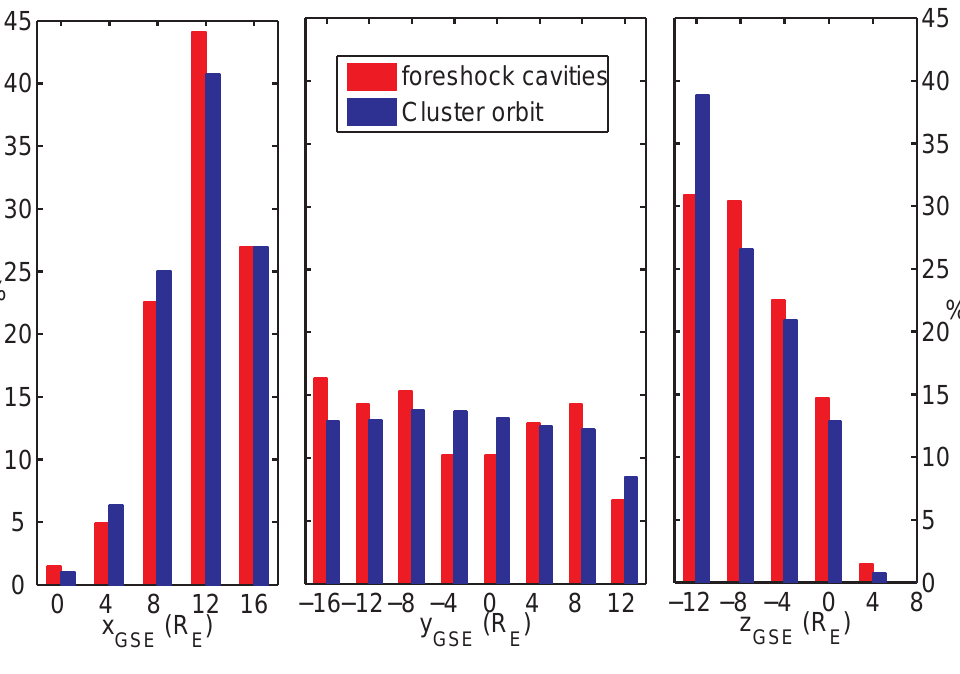
Fig. 3. Histograms of cavity locations projected onto each GSE axis along with hourly averages of the part of the Cluster orbit upstream of the bow shock. In each component, the distributions are similar. Foreshock cavities are observed throughout the Cluster orbit. More cavities are observed outside the pre-noon ( y GSE ≤ 0) bow shock than post dawn; this asymmetry is most likely due to the IMF assuming a spiral orientation.